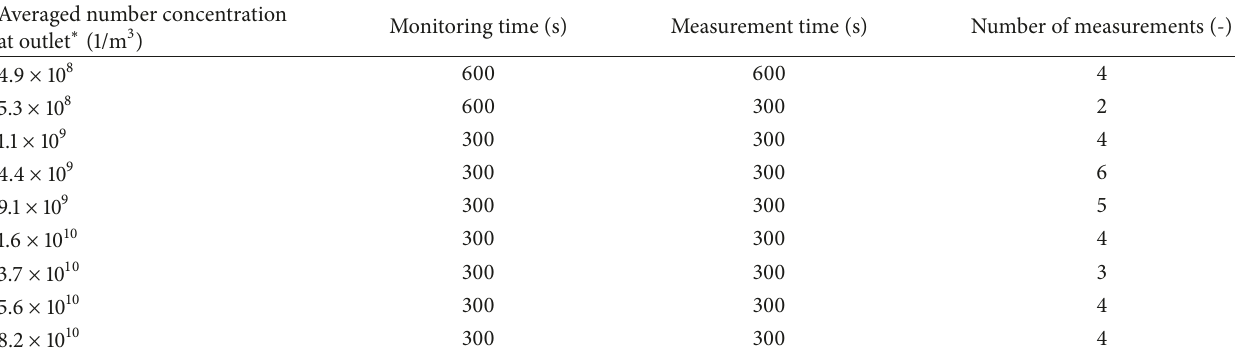
Table 2: Aerosol measurement information of the experiment PW1.